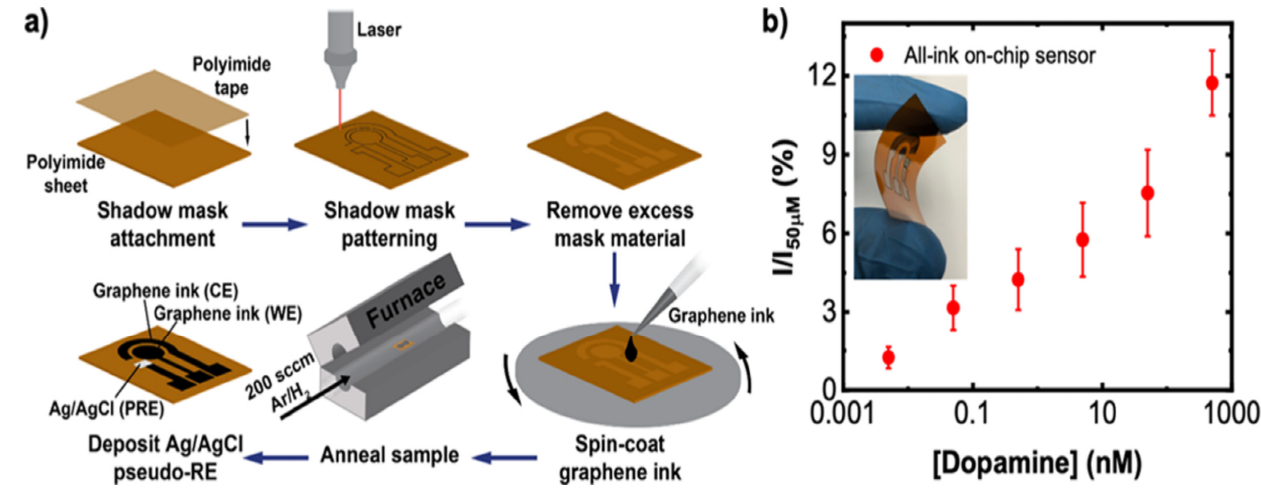
Figure 7. ( a ) Schematic representation of one-step thermal annealing process of graphene ink for a Dopamine sensor on a polyimide sheet. ( b ) Optical image of the sensor on a polyimide substrate. Graphic representation of the sensor response to DA in PBS solution. Reprinted with permission from [56]. Copyright© 2021 American Chemical Society.